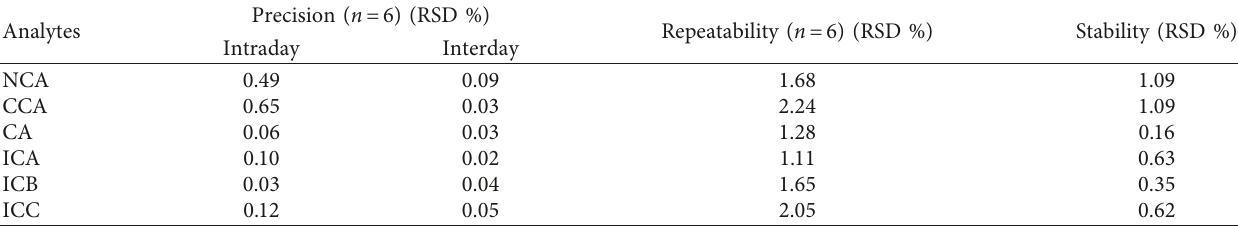
Table 3: Method validation for determination of six CAs.